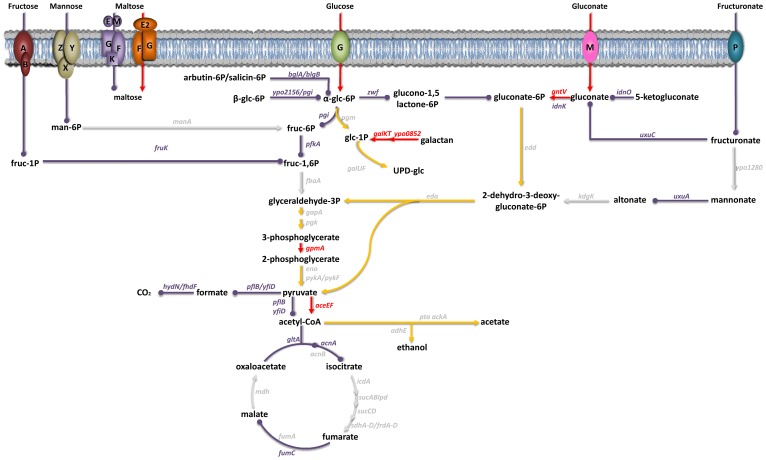
Carbohydrate uptake and metabolism by Y. pestis in its mammalian host.Genes encoding transporters for fructose (FruAB), mannose (ManZYX), maltose (MalEMGKF and MalE2FG), glucose (PtsG), gluconate (GntM) and fructuronate (GntP) and the carbohydrate metabolism genes shown in red or purple were all overexpressed in vivo
[7]. In virulence tests, mutants lacking a gene highlighted in red were virulence-attenuated, whereas those lacking a gene highlighted in purple were not. Genes in grey were not upregulated in vivo and their role in virulence has yet to be elucidated; hence, the importance of the metabolic fluxes involving the corresponding enzymes in virulence is unknown (grey arrows). Red and purple arrows respectively indicate the metabolic fluxes considered to be important and non-essential for virulence. Yellow arrowheads represent the metabolic pathways that glucose and gluconate might follow.